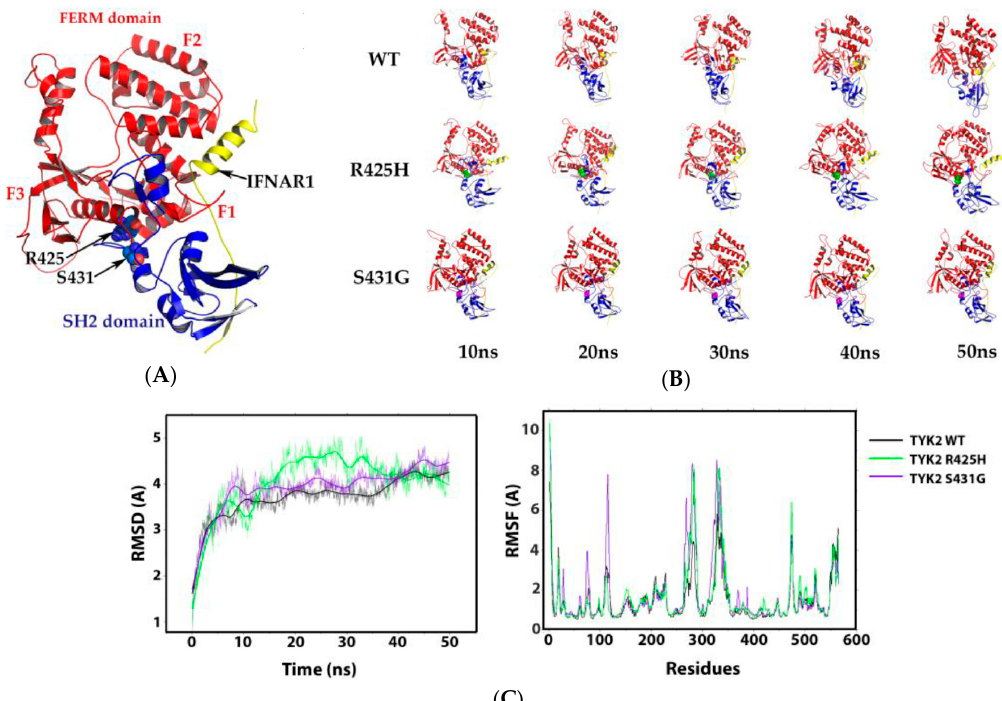
Figure 5. Interaction of four-point-one, ezrin, radixin, moesin (FERM) and src-homology 2 (SH2) domains of TYK2 with IFNAR1 −α / β receptor alpha chain (IFNAR1). ( A ) 3D representation of the interaction of TYK2 FERM and SH2 domains with IFNAR1 (ID PDB: 4PO6). FERM domain is represented by subdomains (F1, F2, and F3) in red, SH2 domain in blue, and IFNAR1 in yellow; the sites of TYK2 R425 and S431 are represented with spheres in the protein structure and are indicated with black arrows. ( B ) Structural models from 0 to 50 ns of molecular dynamics (MD) of the TYK2–IFNAR1 complex, using the WT, R425H and S431G mutants. ( C ) Root mean square deviation (RMSD) and root mean square fluctuation (RMSF) of the TYK2 WT–IFNAR1, the TYK2 R425H–IFNAR1, and TYK2 S431G–IFNAR1 complexes. RMSD as a function of time (left) and RMSF vs. residues (right).